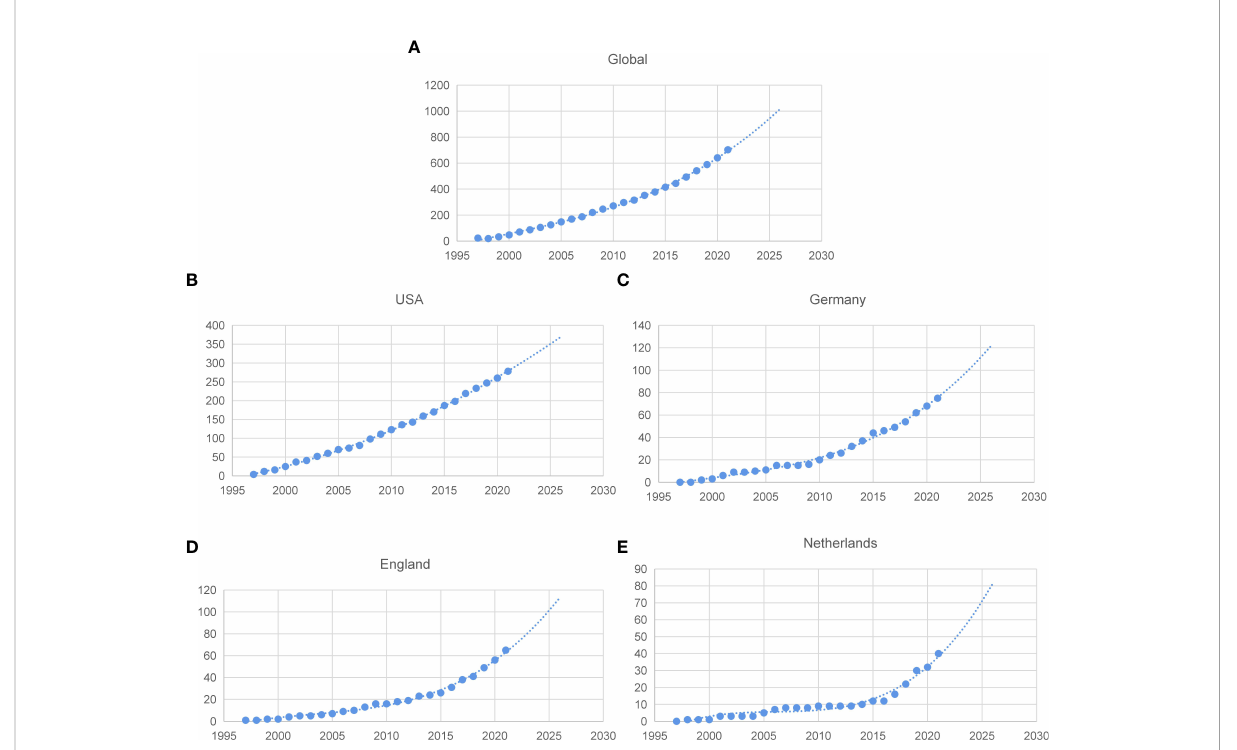
FIGURE 3 Fitting curves of publications growth trends. (A) Global; (B) the United States; (C) Germany; (D) England; (E) Netherlands.